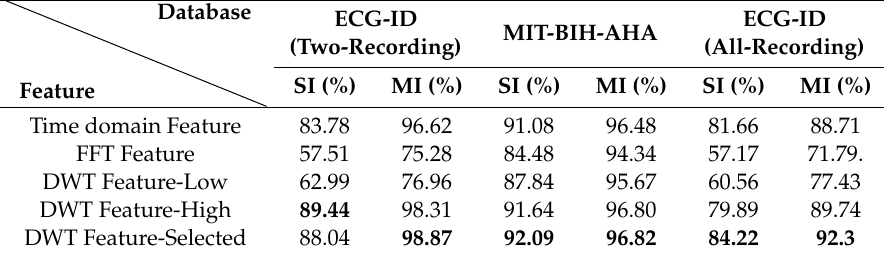
Table 3. Performance comparison of di ff erent features. (SI-Single-heartbeat Identification, MI-Multiple- heartbeat Identification).